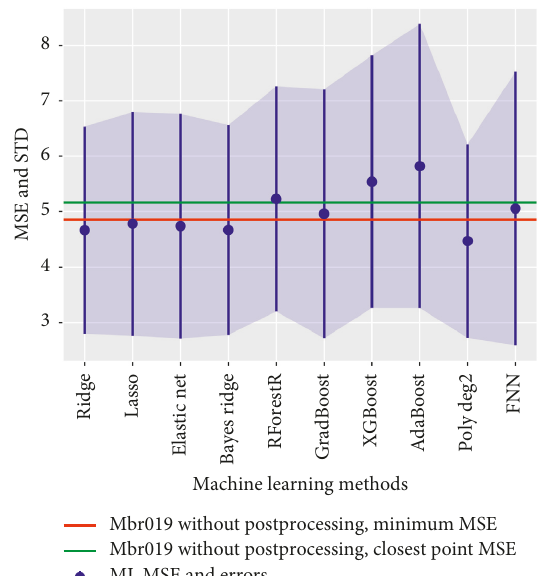
Figure 3: T2m calibration plot for Madrid airport. Horizontal axis, from left to right: ridge, lasso, elastic net, Bayesian ridge, random forest regression, gradient boosting regression, XGBoost re- gression, AdaBoost regression, polynomial of order 2, and feed- forward neural network.